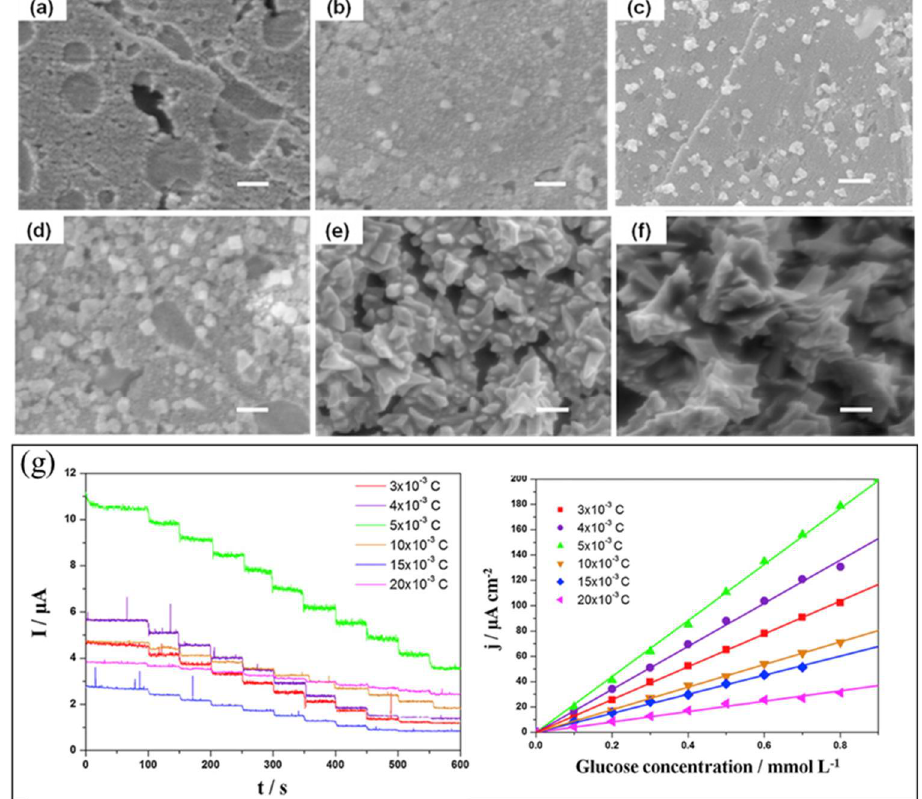
Figure 10. SEM images of Au nanocrystal deposited on the graphene/Au disk electrode under the same potential of −0.2 V with varied electrical quantities: ( a ) 2 × 10 − 3 C; ( b ) 3 × 10 − 3 C; ( c ) 4 × 10 − 3 C; ( d ) 5 × 10 − 3 C; ( e ) 10 × 10 − 3 C; and ( f ) 15 × 10 − 3 C. ( g ) The current signal of the amperometry response of the GOx/AuNC/graphene/Au disk electrode with varying electrical charges. Reprinted with permission from ref. [143]; Copyright 2015 Elsevier.